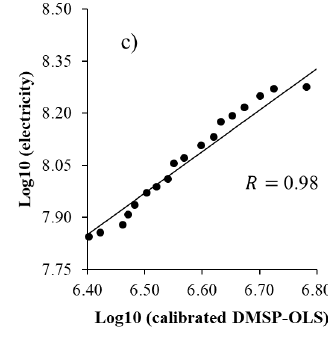
Figure 5. Sum of DMSP-OLS SNT data based on ( a ) intra-annual composition and ( b ) inter-annual series correction.